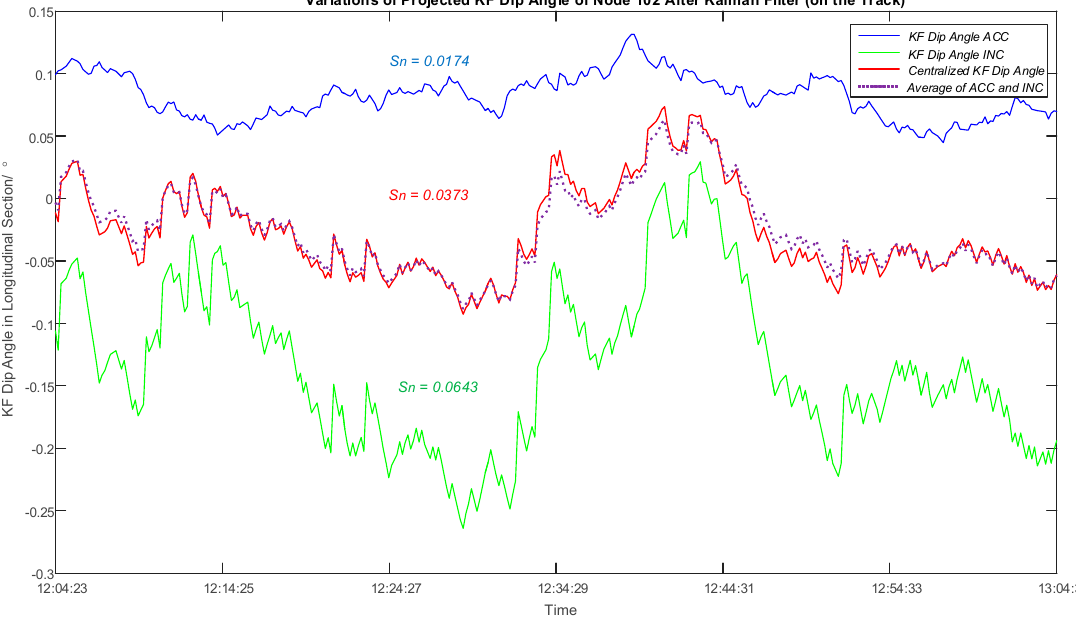
Figure 12. Plots of Dip Angle Variations after Kalman Filter of Node 102 (on the Track) in the Longitudinal Section During the Second Measuring Hour. Blue and green lines are results after Kalman filter for the accelerometer and inclinometer respectively, and the red line shows the result solved by a centralized Kalman filter based on the tilt values from two sensors. The standard deviation of the red line is higher than that of the blue line and lower than that of the green line. The purple dot line displays the average of the blue and green lines.